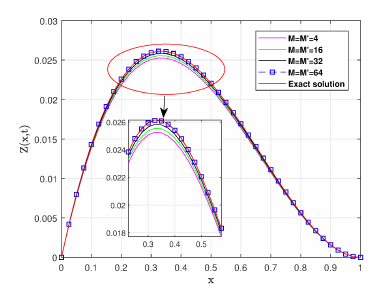
Figure 4. The comparison between the exact solution and the approximate solutions with m = m ′ = 1, η = η 1 = 1 2 and different values of M = M ′ for Example